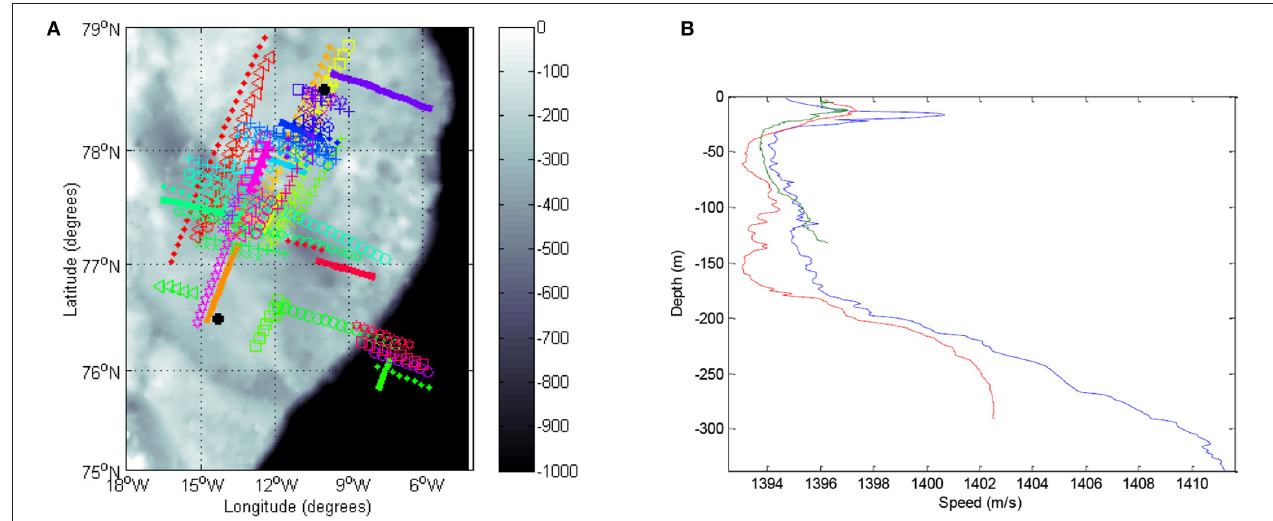
FIGURE 1 | Overview of the deployment area: (A) survey vessel and recorder positions together with bathymetric information (the color bar shows the depth in meters); (B) Sound speed profiles at the two recorders (red: Greenland I, green: Greenland II) and a location in between the two recorders